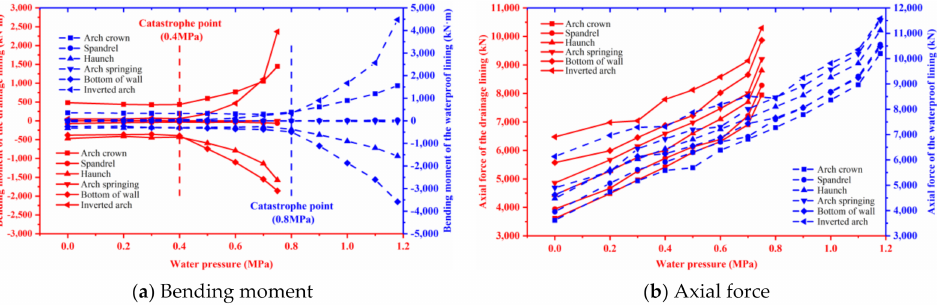
Figure 14. Relationship between the internal forces and the water